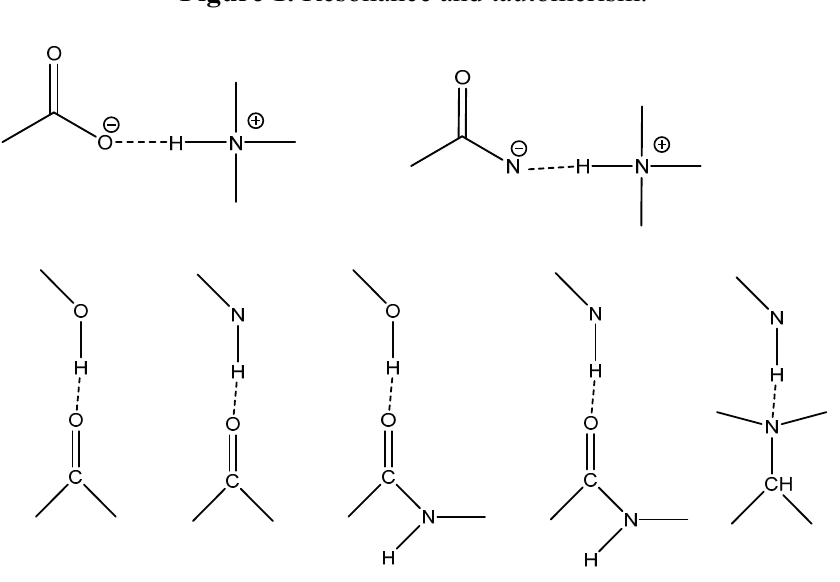
Figure 1. Resonance and tautomerism.